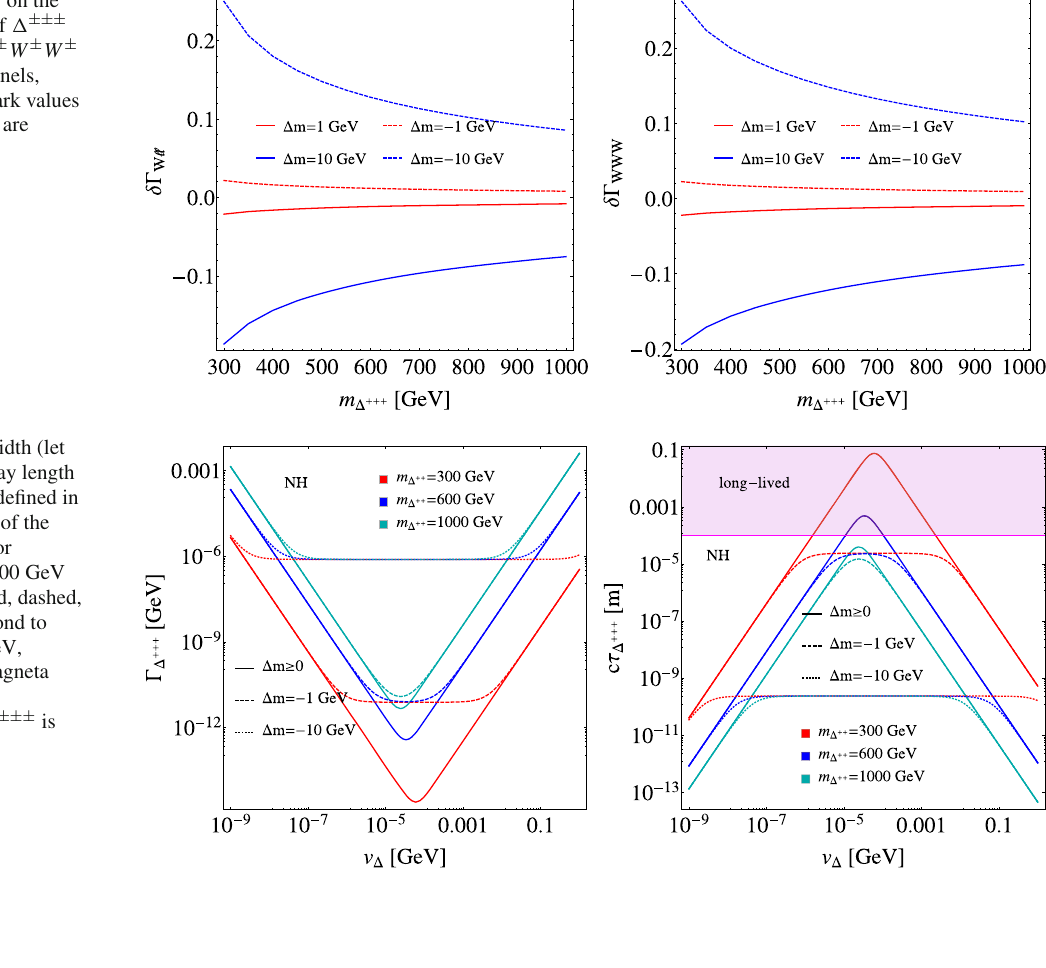
the NH. The shaded regions represent the branching ratios in the lep- tonic decay and gauge boson decay channels for v (cid:2) (cid:2) 10 − 4 . 5 GeV and v (cid:2) (cid:3) 10 − 4 . 5 GeV, respectively. The blue curves denote the branching ratio in the cascade decay channel